Question: Describe this figure in one sentence.
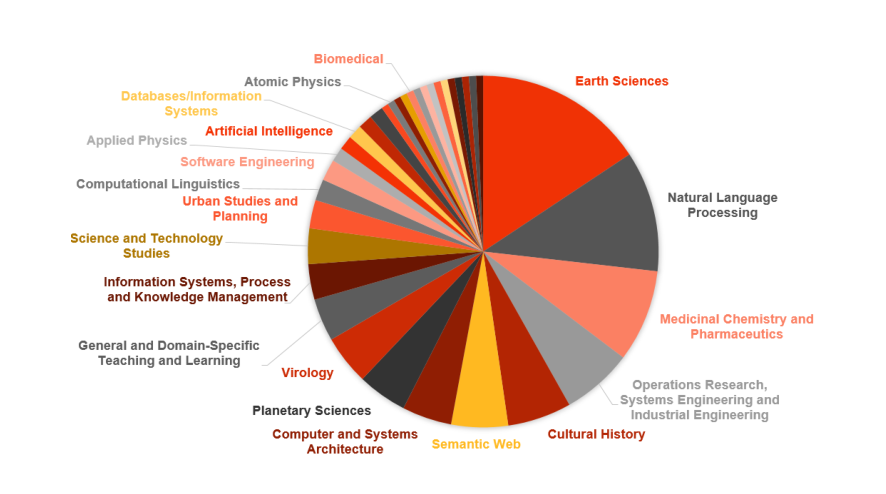
Answer: Research field distribution of the selected papers in our evaluation dataset con- taining domain-expert human-annotated properties that were applied to represent the paper’s structured contribution descriptions in the Open Research Knowledge Graph (ORKG).